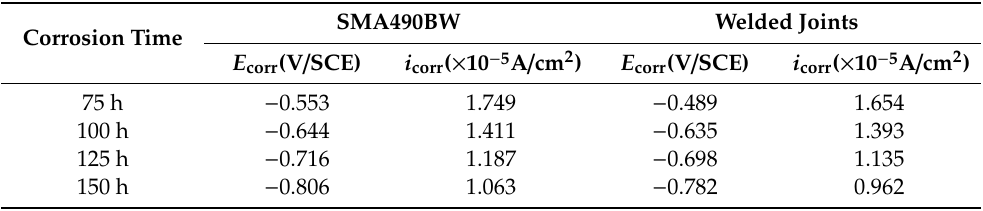
Table 4. Electrochemical parameters obtained from the polarization curve of SMA490BW steel and its welded joints.